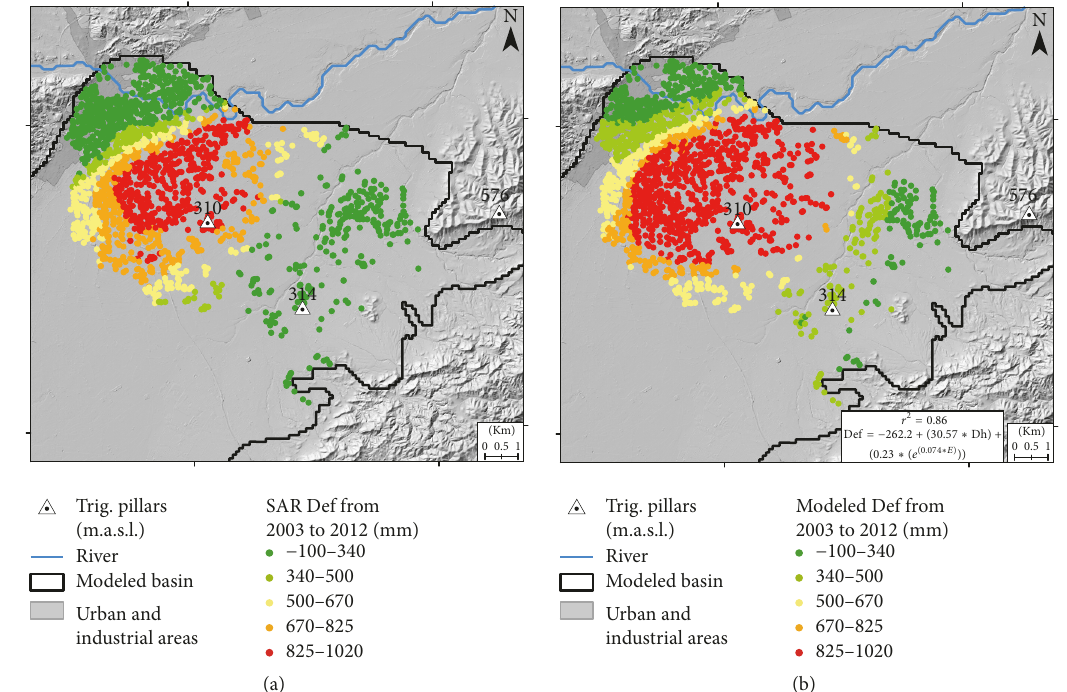
Figure 11: Results of the surface deformation modeled for the period 2003–2012 (ENVISAT + Cosmo-SkyMed). (a) SAR deformation measured from 2003 to 2012. (b) Calculated deformation using an exponential thickness model.